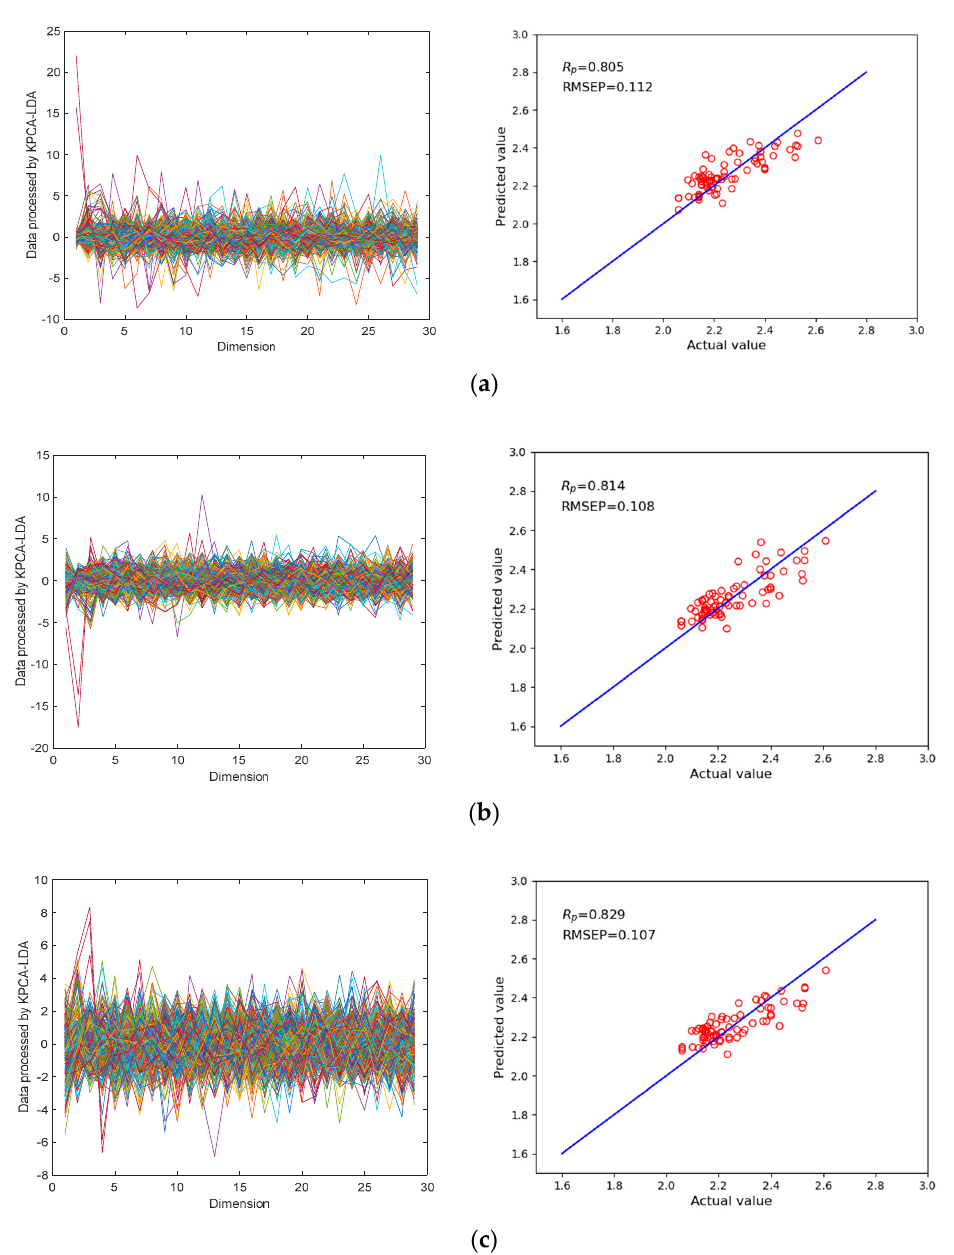
Figure 7. Comparison of the prediction results of the linear kernel function with other kernel functions in the KPCA-LDA- XGB model. ( a ) Prediction results of the KPCA(RBF)-LDA-XGB model. ( b ) Prediction results of the KPCA(Poly)-LDA-XGB model. ( c ) Prediction results of the KPCA(linear)-LDA-XGB model. Table 4. Comparison of the prediction and cross validation performance of the linear kernel func- tion with the other kernel functions in the KPCA-LDA-XGB model.